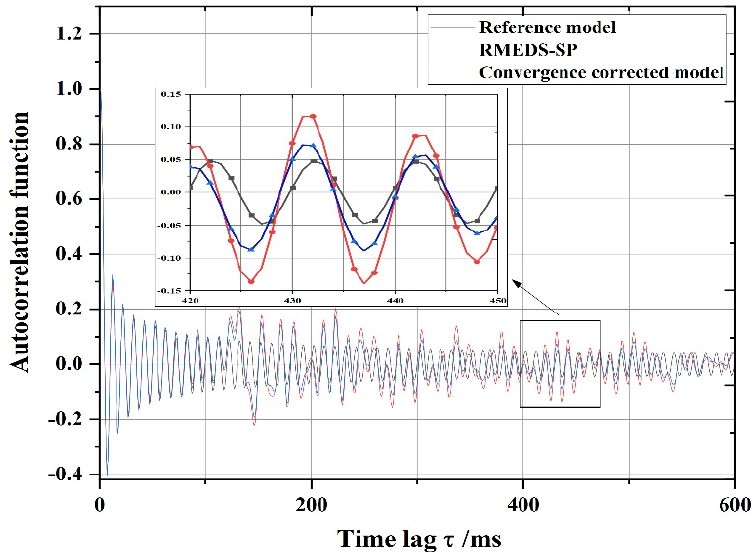
Figure 12. ACF of RMEDS-SP and after error compensations.